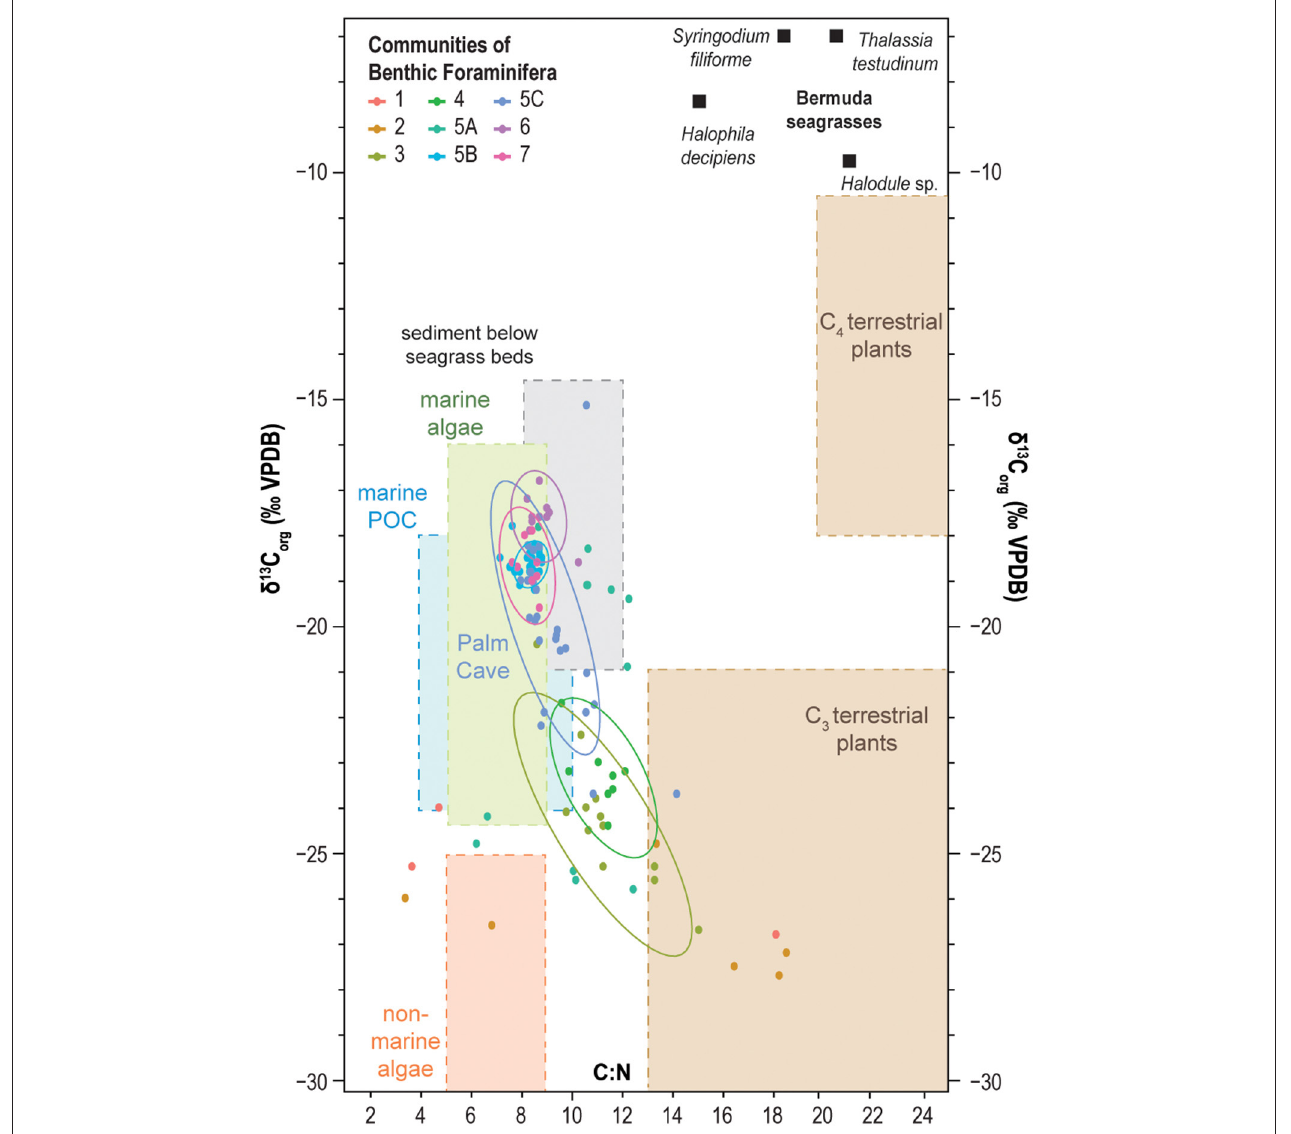
FIGURE 6 | Crossplot of δ 13 C org values and C:N ratio of bulk sediment from the Palm Cave (this work), Green Bay Cave (van Hengstum and Scott, 2011), Cow Cave, and Deep Blue (Little and van Hengstum, 2019). Samples are grouped according to their benthic foraminiferal communities. Colored ellipses correspond to 95% confidence intervals around the mean values for selected groups. The values of δ 13 C org and the C:N ratio of other organic carbon pools are compiled from the literature (Lamb et al., 2006; Kennedy et al., 2010; Fourqurean et al.,